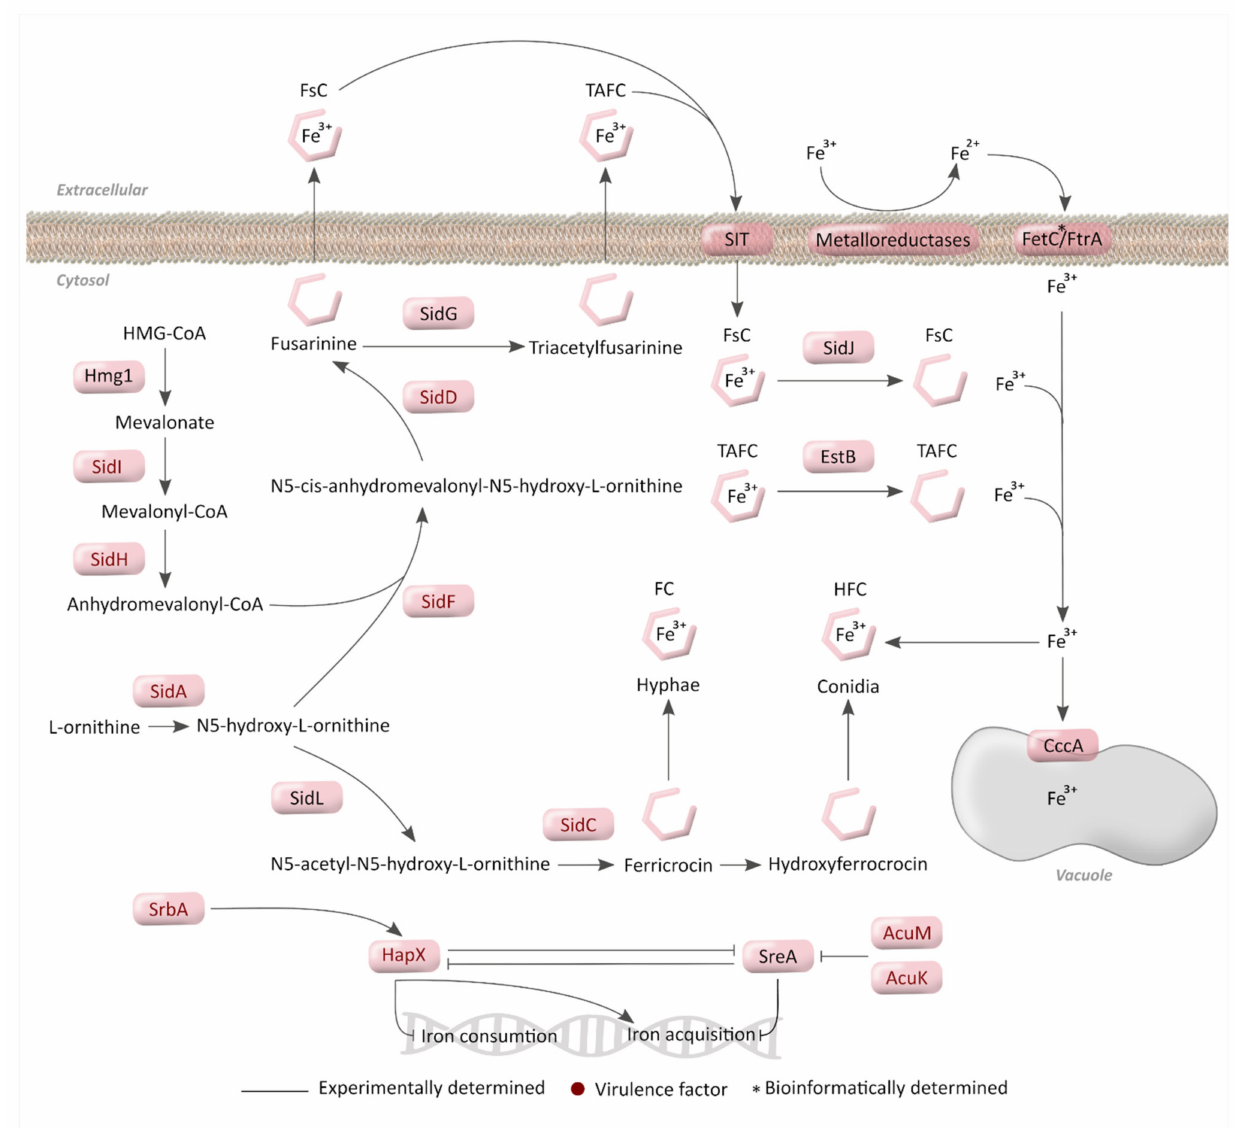
Figure 3. Iron sensing, uptake, metabolism, and regulation in A. fumigatus . Iron enters the fungal cell through metal permeases (low affinity), siderophores uptake (high-affinity), or FetC/FtrA protein part of reductive iron assimilation (RIA) (high-affinity). Genes in the Sid family are in charge of the biosynthetic route of extracellular siderophores, FsC and TAFC, and intracellular siderophores, FC and HFC. Siderophores transport Fe 3+ inside the cell where vacuole or intracellular siderophores store it. HapX and SreA regulate iron to acquire it when necessary and increase its consumption when there is an excess, to avoid metal